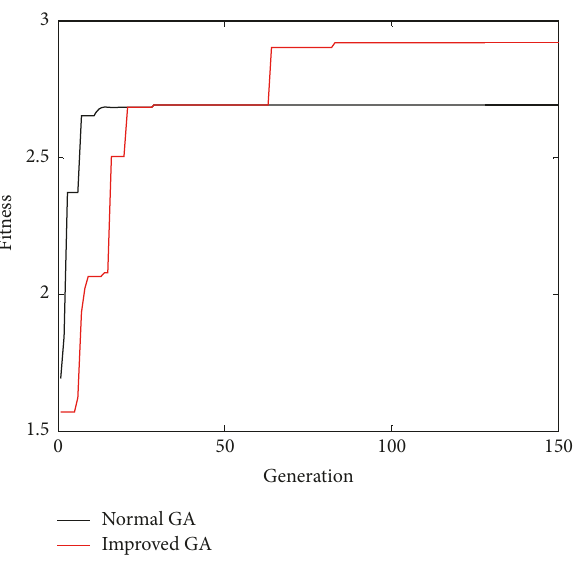
Figure 12: Two evolutionary curves’ algorithm for airplane image.